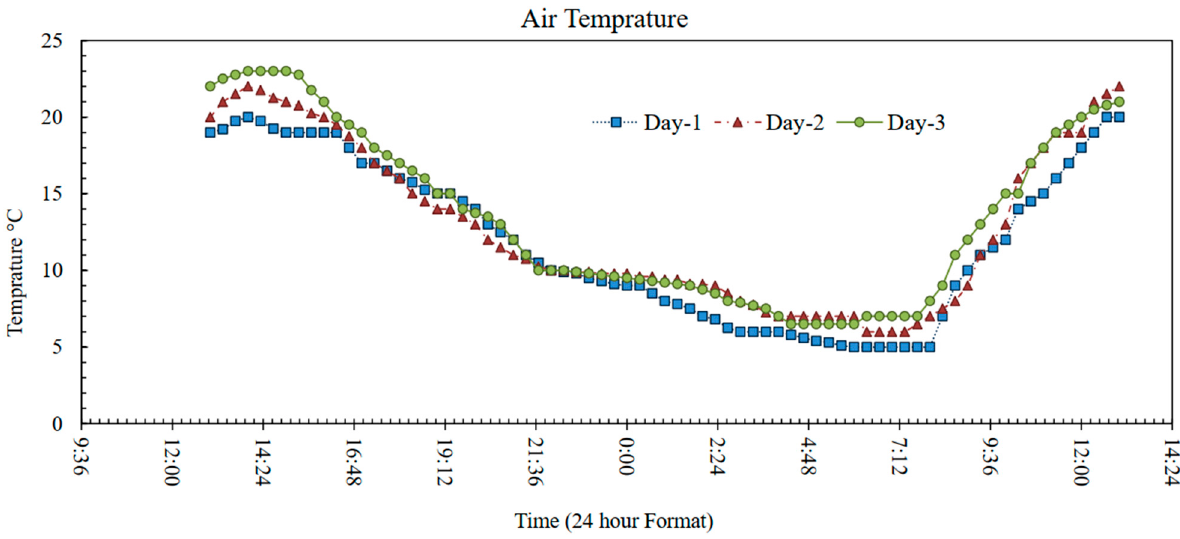
Figure 9. The variation of temperature during 24-h data acquisition over three days.